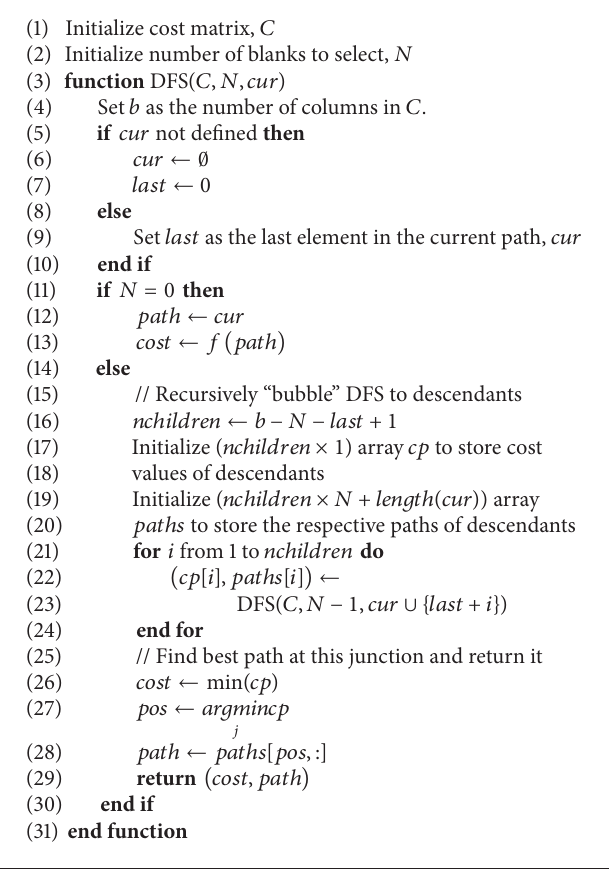
Algorithm 1: Pseudocode for Recursive Depth-First